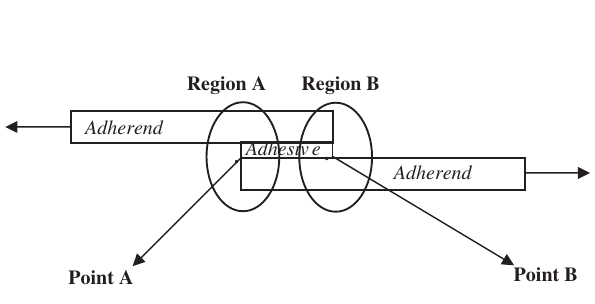
Figure 4 Stress singularity regions.